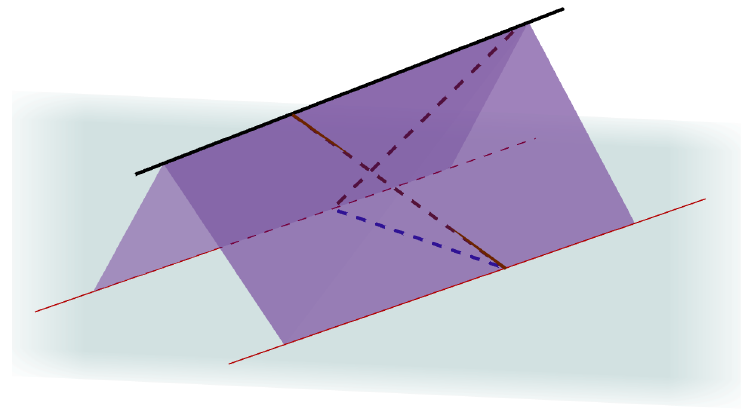
Figure 8 . The figure shows schematically the infinite long pre-entanglement wedge W ξ of (blue) single boundary interval bounded by two (purple) null sheets N and boundary domain of dependence ± (bounded by two red lines) in planar BTZ spacetime. For clarity we do not show explicitly the horizon here. Note that the whole W lies completely outside the black hole ξ